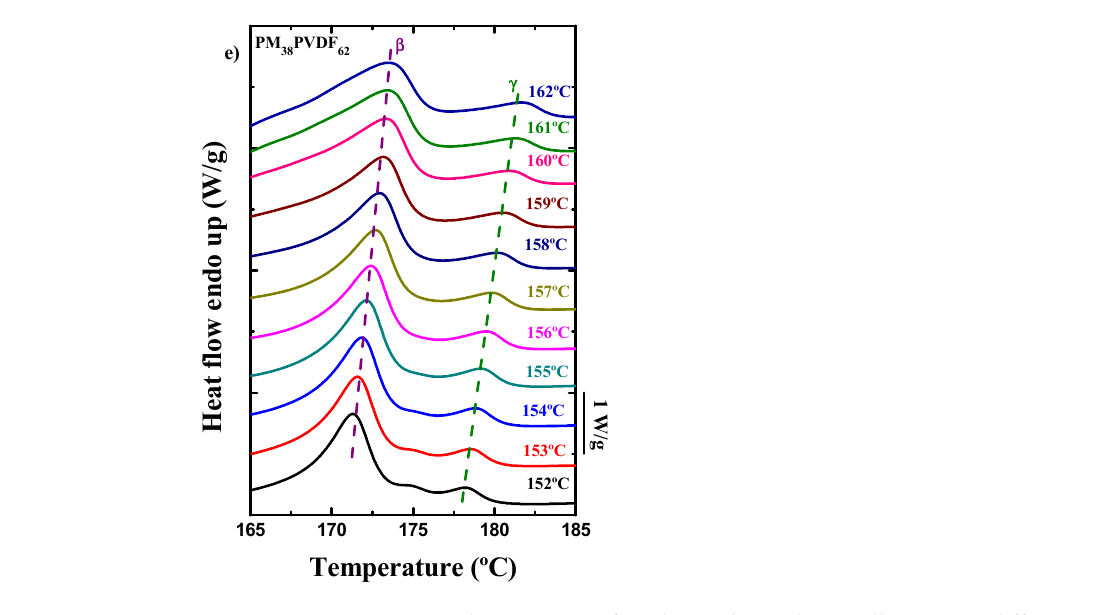
increment). Figure S5: Values of the intensity of the colours against the temperature during the cooling process at 20 °C/min using the Image J software of (a) PM 23 - b -PVDF 77 and (b) PM 38 - b -PVDF 62 . Figure S6: Melting temperatures against crystallization temperatures with their respective linear fit